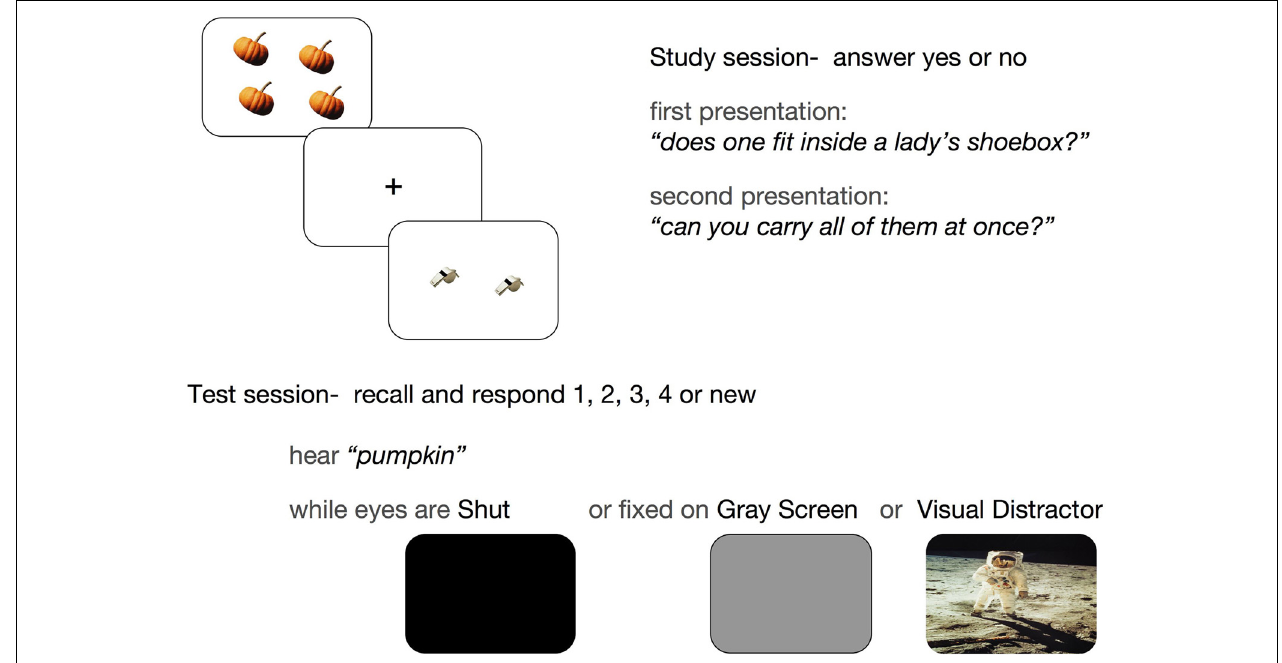
FIGURE 1 | Experimental paradigm. A schematic of the procedure shows the study session, when participants answered two incidental questions about each of 168 images (3s per presentation), and the test session, when